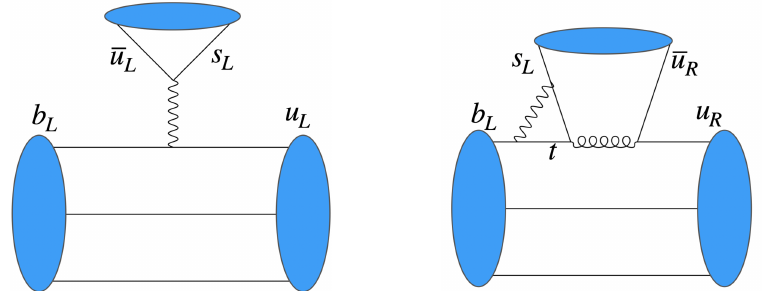
Figure 1. Topological diagrams for the color enhanced processes in B b → B n P , where the left and right figures are associated with the CKM coefficients of V ub V ∗